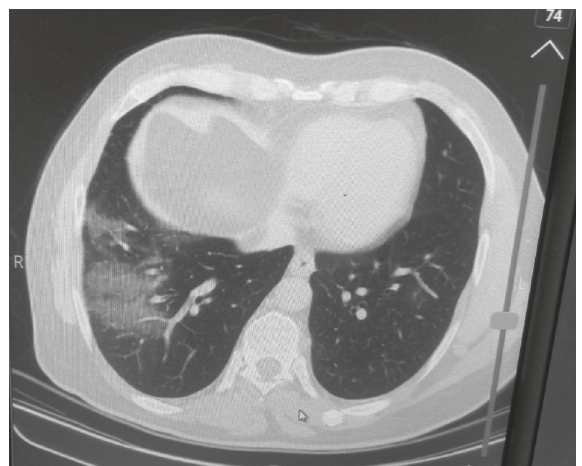
Figure 1: Lung CTscan of the patient at previous admission shows moderate involvement of the patient’s lungs.